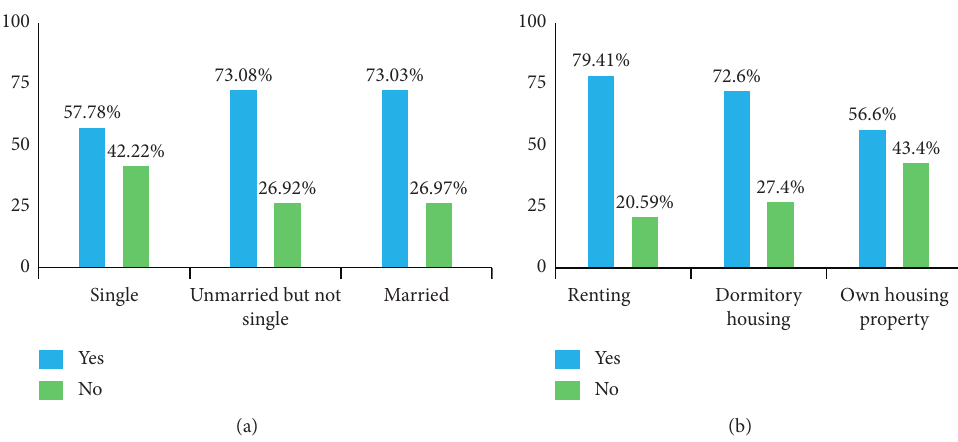
Figure 4: Breakdown of choice behavior according to family status and